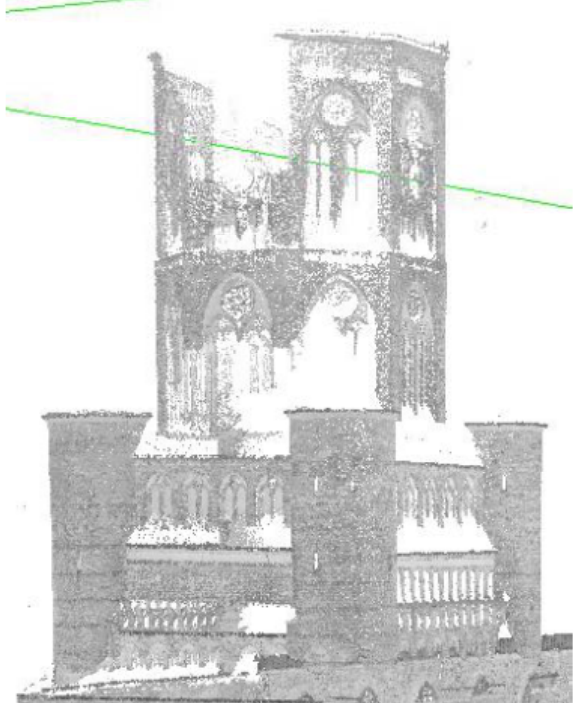
Figure 7. TLS-point cloud of the tower between 44 m to 60 m height (view from Southwest) These areas were cut out from both point clouds and the point cloud. Differences compared to the TLS as reference method were determined using CloudCompare (OpenSource, Daniel of the naves and have surface areas of 128-330 m², figure 6. The distance values were statistically analyzed (e.g. histogram, mean, standard deviation).